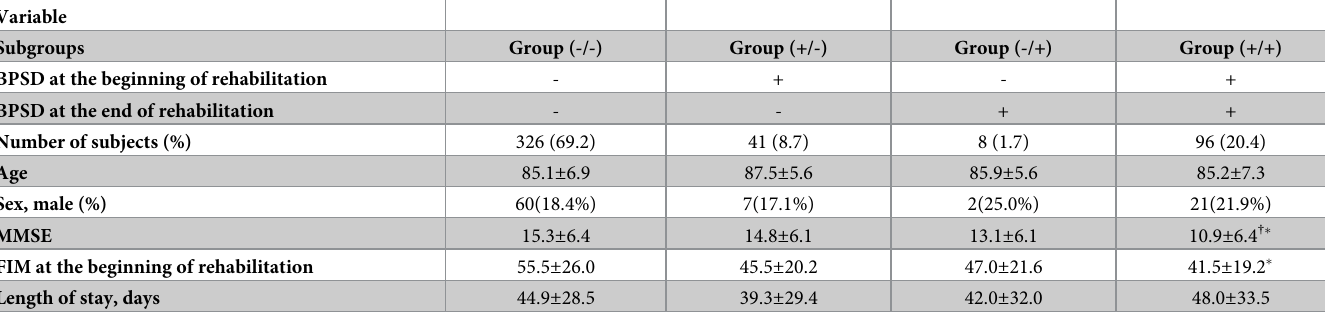
Table 3. Characteristics of older individuals among subgroups divided by behavioral psychological symptoms of dementia